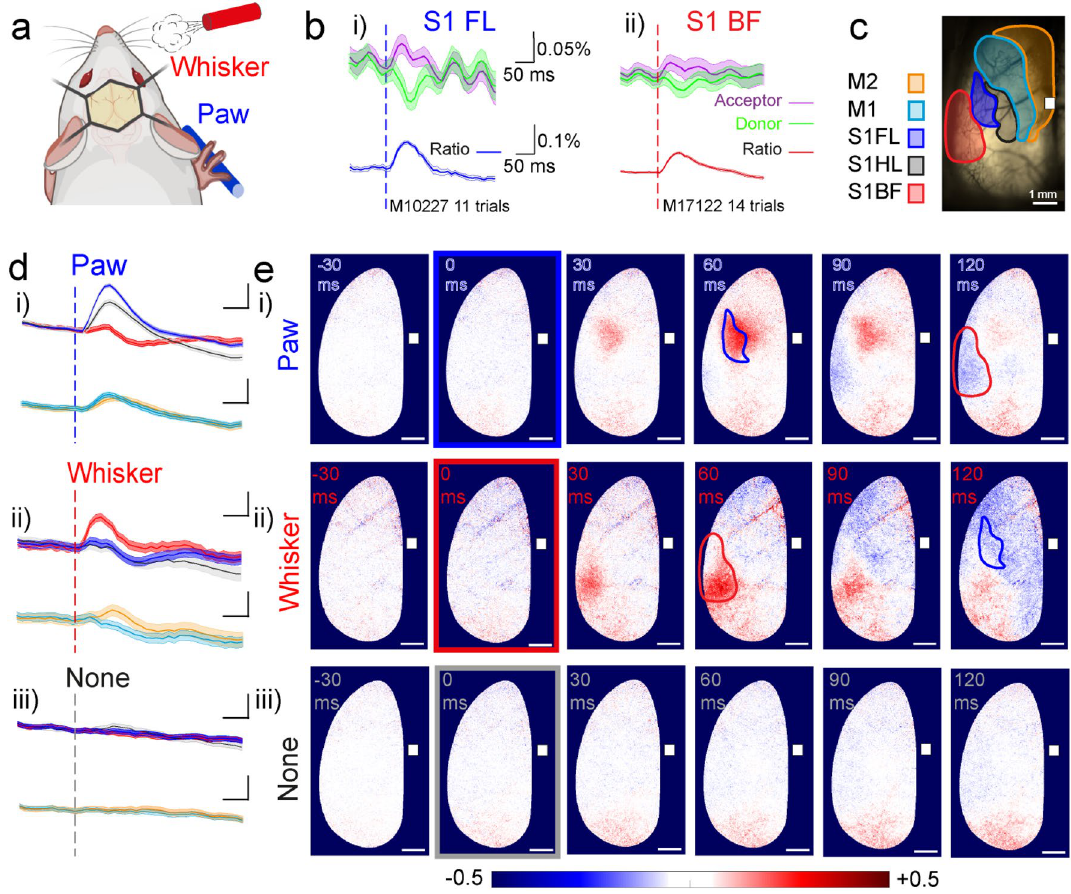
Figure 1 . Distinct voltage response patterns across cortical areas following forepaw and whisker sensory stimulation (“Results”; “Discussion”). ( a ) Diagram showing awake, head-fixed mice expressing VSFP Butterfly 1.2 in Layer 2/3 cortical pyramidal neurons, with a thinned-skull cranial window receiving forepaw and whisker stimulation. Blue and red colours indicate paw and whisker stimulation, respectively in this and all following figures. Mouse image created with Biorender.com. ( b ) (i) Sensory-evoked donor (green) and acceptor (purple) fluorescence responses (ΔF/F) induced by light forepaw stimulation spatially averaged over the contralateral forelimb area (S1FL) in a single mouse id M10227. Corresponding ΔR/R ratiometric traces represent the voltage response, blue trace. Vertical dashed line indicates stimulation onset. n = 11 trials. (ii) Same as in (i), sensory- evoked responses to a short air puff directed to the whiskers, onset indicated by the vertical red dashed line. Responses are spatially averaged over the contralateral Barrel Field (S1BF) for single mouse id M17122, n = 14 trials. ( c ) Through-skull cranial window with mapped areas according to “The Mouse Brain in Stereotaxic Coordinates” 48 , relative to bregma. (M1, Primary motor cortex; M2, secondary motor cortex; S1HL, Hindlimb area of the primary sensory cortex; S1FL, Forelimb area of the primary sensory cortex; S1BF, Barrel field of the primary sensory cortex). Bregma shown with a white square. ( d ) Sensory-evoked voltage responses spatially averaged from areas S1FL (blue), S1HL (black), SIBF (red), M1 (cyan) and M2 (orange) in response to forepaw stimulation (i), whisker stimulation (ii) and control trials with no stimulation (iii). Note the hyperpolarisation of S1BF in response to paw stimulation, (i), and the hyperpolarisation of S1FL in response to whisker stimulation (ii). Vertical dashed line indicates stimulation onset. ΔR/R for ratiometric trace. (Paw stimulation n = 118 trials, 12 mice. Whisker stimulation n = 52 trials, 10 mice. No stimulation n = 152 trials, 12 mice), scalebar 0.1% ΔR/R and 50 ms. ( e ) Sensory-evoked voltage maps in response to paw stimulation (i), whiskers stimulation (ii) and no stimulation trials, none (iii) at 30 ms before (− 30 ms), at the stimulation time (0 ms, framed in blue, paw, or red, whisker) and selected times after each stimulation. Maps contain the same data as the traces in D. Depolarised pixels red, + 0.5% ΔR/R and hyperpolarised pixels blue, − 0.5% ΔR/R. Scale bar 1 mm. Bregma shown with a white square. Paw stimulation evoked a depolarization in S1FL (area outlined in blue) 60 ms after the stimulation and a hyperpolarization of S1BF (area outlined in red) 120 ms after the stimulation. Whisker stimulation evoked a depolarization in S1BF 60 ms after stimulation and a hyperpolarization, in S1FL 120 ms after the stimulation. Side by side videos of whisker and paw stimulation are found in Supplementary Video